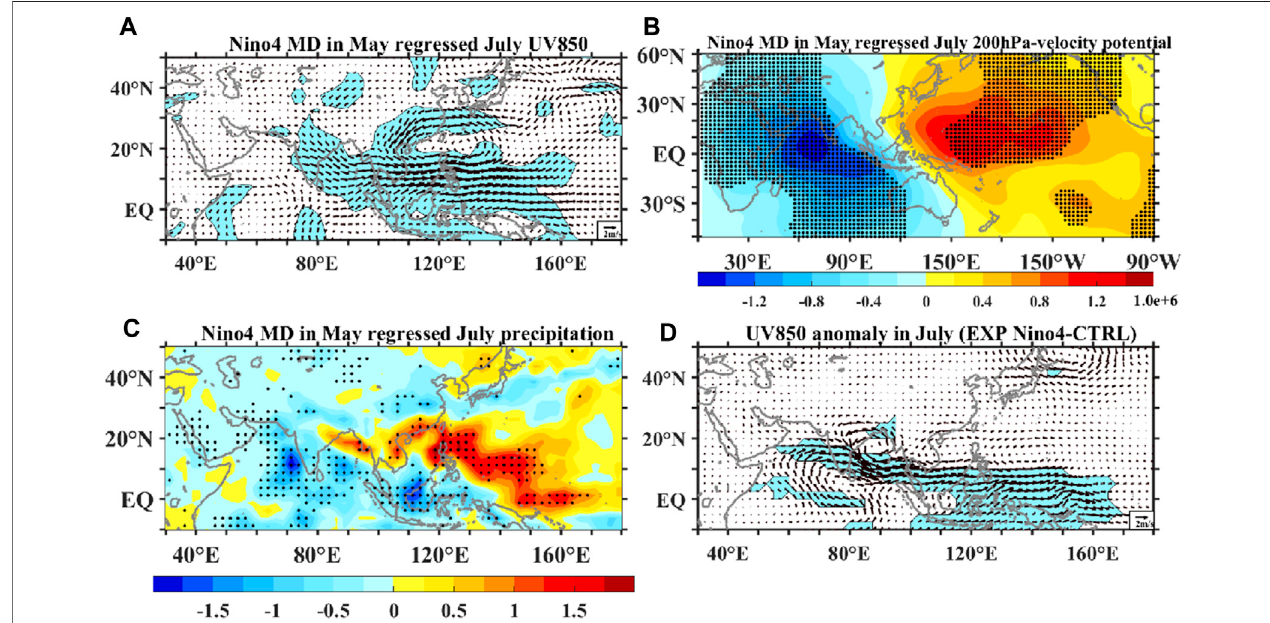
FIGURE 10 | Regression patterns of the July (A) UV850 anomaly (units: m/s), (B) velocity potential at 200 hPa (units: 10 6 m 2 /s), and (C) precipitation anomaly (units: mm/day) upon the standardized July Niño4 MD index during 1980 – 2020. (D) UV850 (units: m/s) in July during 1971 – 2000 from EXP Niño4-CTRL. Dotted (b, c) and shaded (a, d) areas indicate statistical signi fi cance at the 95% level, as estimated by a Student ’ s t -test.